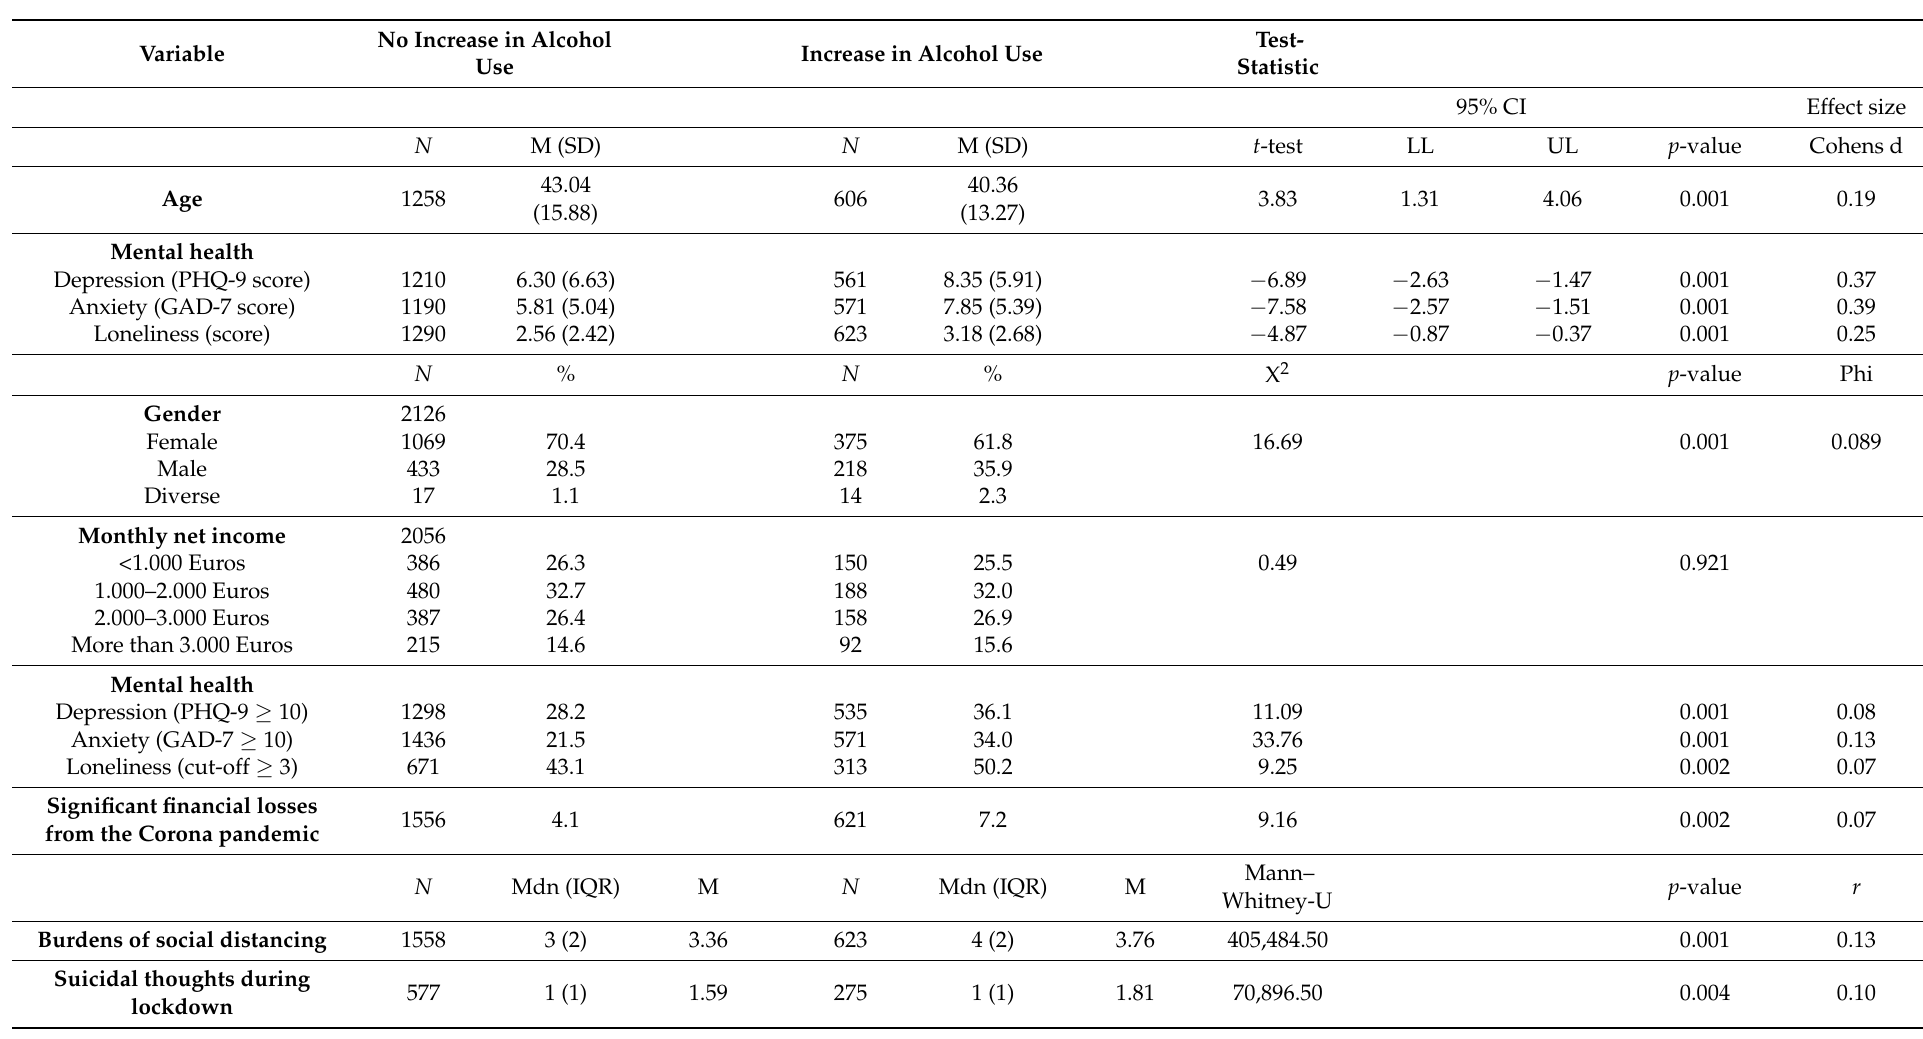
Table 6. Alcohol use and mental